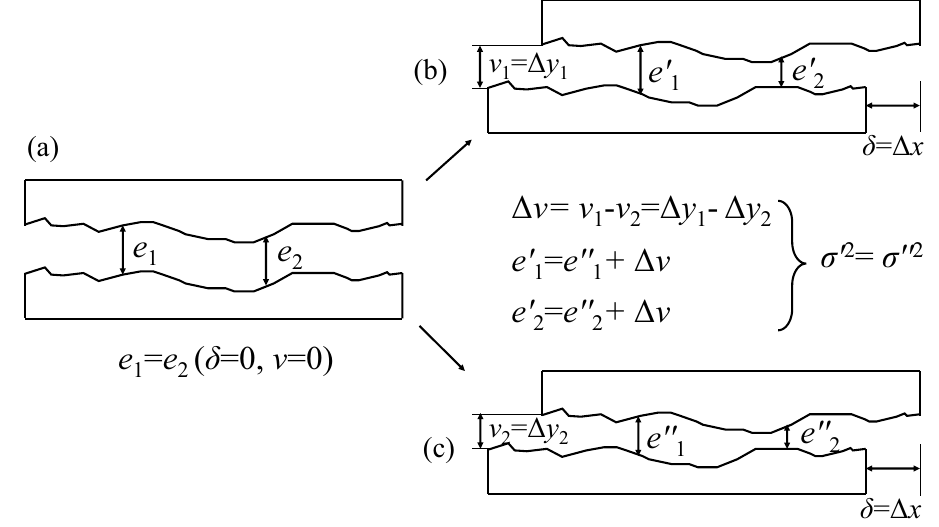
Figure 8. Conceptual diagram of the calculation of the thickness variation under different normal